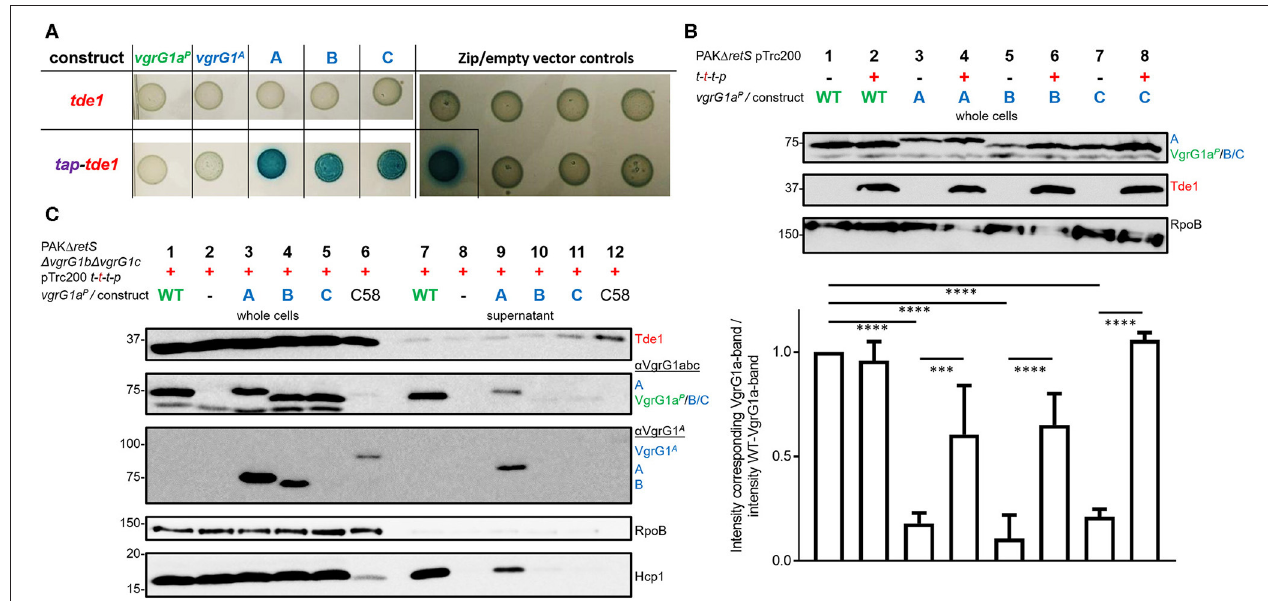
FIGURE 4 | All chimeras interact with Tde1 but are unable to facilitate effector secretion. (A) T25 and T18-domains were fused to the C-termini of either VgrG or a catalytic mutant of Tde1 (red) in presence of the cognate Tap1 (purple). Representative bacterial-two-hybrid plates tested for interactions between VgrG1a P -G1 A -chimeras and Tde1 on its own (top panel) or in presence of the Tap1 protein (bottom panel) (Bondage et al., 2016). All interactions were tested with all gene sequences cloned into both pKT25 and pUT18C represented as two columns for each tested interaction. Empty vector controls as well as the leucine- zipper pUT18C- Zip and pKT25- Zip vectors are shown in the right panel. (B) Top panel: Representative western blot of whole cell lysates of PAK 1 retS containing pTrc200 and expressing chimera A, B, C between VgrG1a P and VgrG1 A in absence (–) and presence ( + ) of tap1-tde1-tdi1-paar ( t-t-t-p ). As a control for VgrG1a P stability, the parental strain was included and grown in absence and presence of t-t-t-p (lanes 1 and 2). Antibodies were used against VgrG1abc, Tde1, and RpoB as indicated on the right. Bottom panel: Intensity of the corresponding VgrG1a P bands from three independent experiments was quantified using ImageJ (https://imagej.nih.gov/ij/ index.html) and divided by the intensity of the band belonging to WT VgrG1a P in absence of Tde1 (lane 1) as a standard for VgrG1a stability. One-Way ANOVA with Tukey’s multiple comparison test was conducted between datasets as indicated with **** p < 0.0001. (C) Representative figures of western blots from three independent secretion assays of PAK 1 retS 1 vgrG1b 1 vgrG1c pTrc200 expressing chimeras A, B, C between VgrG1a P and VgrG1 A in presence ( + ) of tap1-tde1-tdi1-paar (t-t-t-p) . As a control for Tde1 secretion the supernatant fraction of A. tumefaciens C58 was included (lanes 6 and 12). Antibodies (from top to bottom) against Tde1, VgrG1abc, VgrG1 A , RpoB, and Hcp1 were used as indicated. *** p < 0.001.